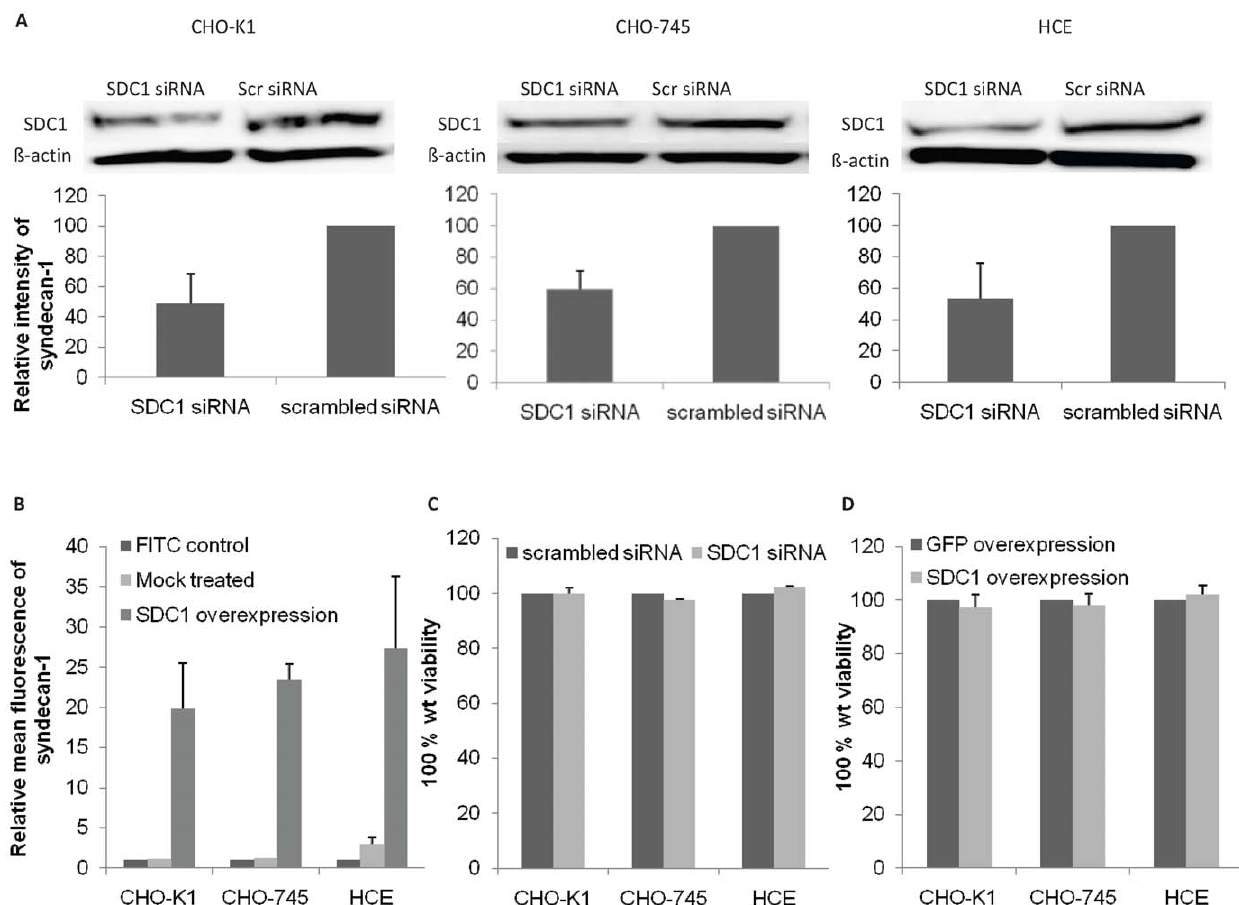
Figure 1. Syndecan-1 knockdown or overexpression do not affect cell viability. (A). CHO-K1, CHO-745, and HCE cells were transfected with scrambled (scr) siRNA or syndecan-1 (SDC1) siRNA. 72–96 h after transfection, immunoblots of cell lysates were prepared and probed with anti-SDC1 polyclonal Ab. b -actin protein level was measured as loading control. Representative blots are shown. Protein bands were quantified using ImageQuant TL image analysis software (version: 7). SDC1 protein expression (mean 6 1SD), normalized to that of b -actin, of at least three independent experiments was quantified by calculating the relative intensity of each syndecan-1 band relative to the control scrambled siRNA treated bands, and presented as bar graph. (B) Cells were grown in 6-well plates, mock treated or transfected with human SDC1 plasmid for 48 h. Cell surface level of SDC1 was evaluated by flowcytomety. FITC stained cells were used as background control. Results are representative of two independent experiments (C, D). Cells were grown in 96-well plates, transfected with scrambled siRNA or SDC1 siRNA for 48 h (C), or transfected with control GFP plasmid or human SDC1 plasmid for 24 h (D). Triplicate wells were evaluated for cell viability using MTS assay. Results are expressed as 100% wild type (wt) viability where they represent the percent corrected absorbance after subtracting the background absorbance, relative